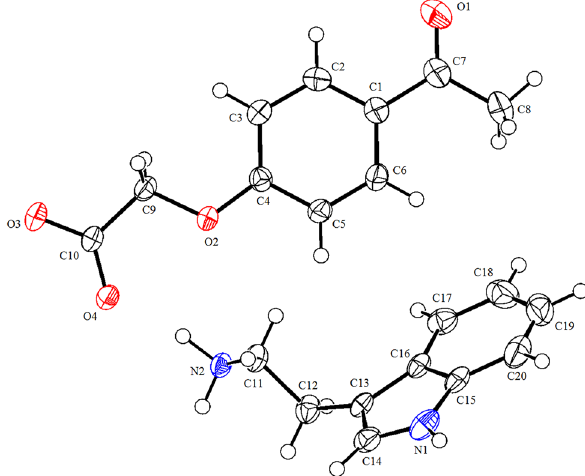
Table 1 contains crystallographic data and Table 2 contains the list of the atoms including atomic coordinates and displacement parameters.